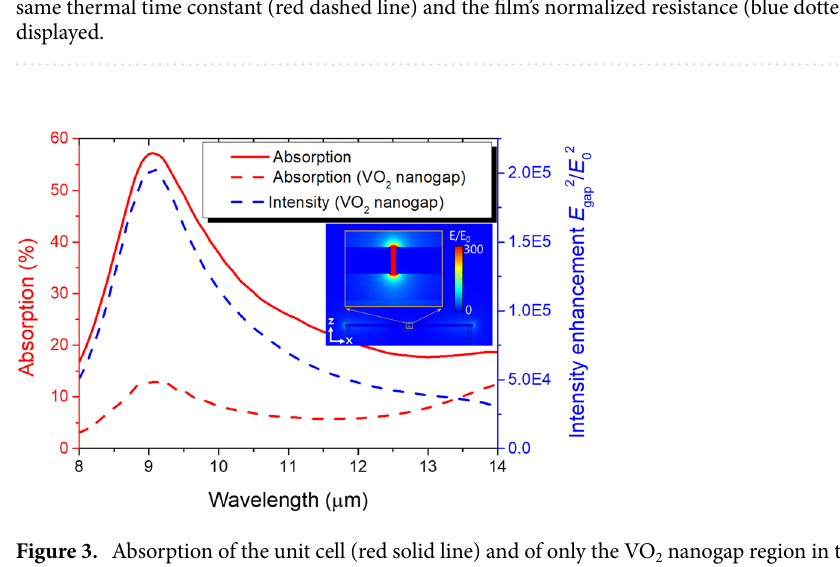
Figure 3. Absorption of the unit cell (red solid line) and of only the VO 2 nanogap region in the unit cell (red dashed line) and the electric field intensity enhancement in the VO 2 nanogap (blue dashed line). The inset illustrates the cross-sectional electric field distribution at the resonance wavelength, 9.05